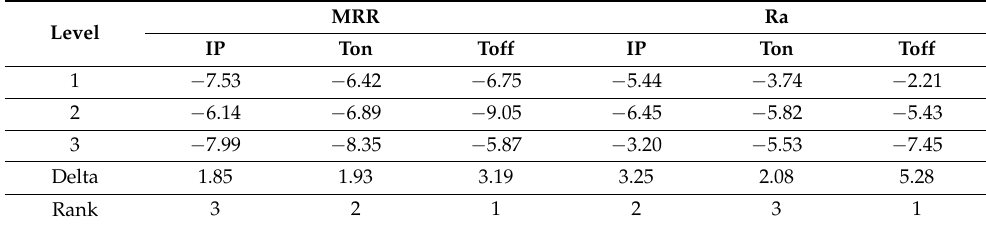
Table 4. S/N ratio response for the cryogenically treated